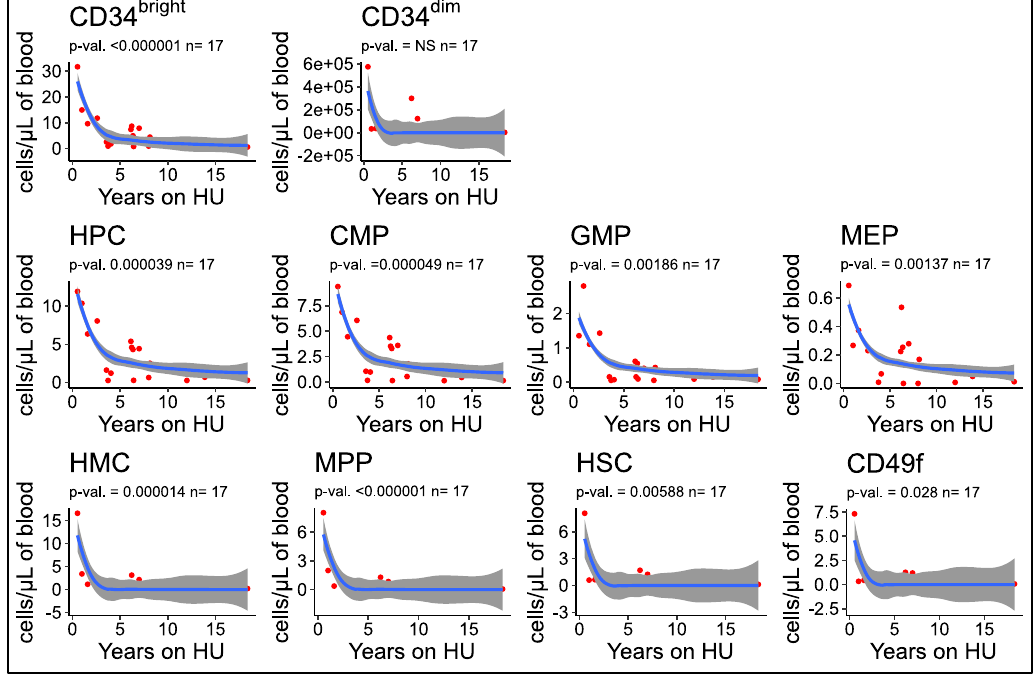
Figure 6. Concentrations of HPSCs decrease as a function of length of HU treatment. Plots illustrating the concentration of HSPCs / µ L of blood as a function of the length of HU treatment. Data was fitted using a power function and p-values were calculated using the R glm package. The concentrations of CD34 bright and HSPCs decrease with length of time of HU treatment. The concentration of CD34 dim cells does not exhibit any significant time dependency. Red curve represents the best fit line for the power model (y ~ log(x)). ( p -values for the model are provided above). Grey smooths represent the 95% confidence interval of the power